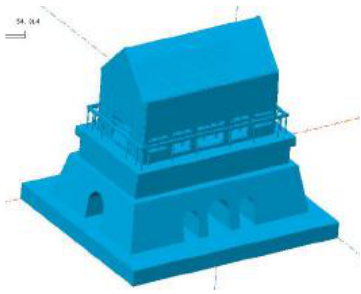
Figure 11. Overall geometric model